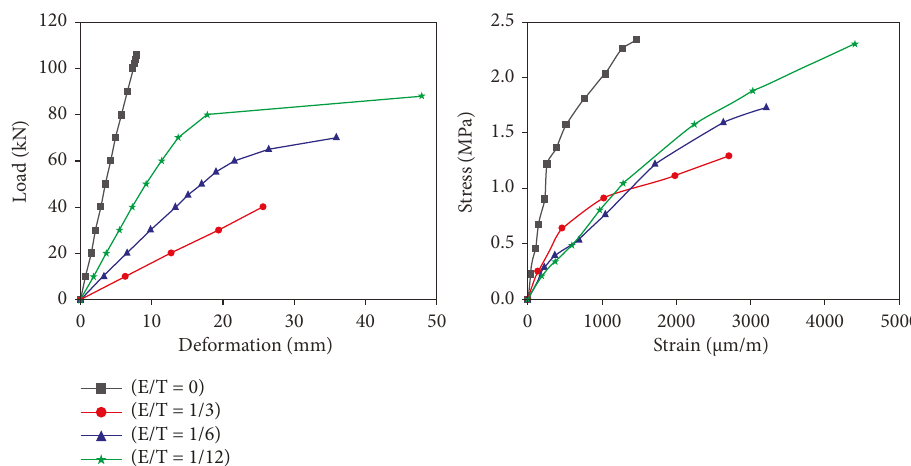
Figure 7: Load-deformation curve and stress-strain curves at the centre for CSRE specimens with H/T � Figure 7. The stress value of the specimen almost remains the same for the eccentricities 0 and 1/12, whereas on average, it decreases by about 25% when the eccentricity is increased from 1/6 to 1/3. The strain within the specimen decreases by 43.66% on average as eccentricity is increased from 1/12 to 1/ 3, whereas the strain value for eccentricity 0 is about 3 times lesser than that of eccentricity—1/12 as shown in Table 3.